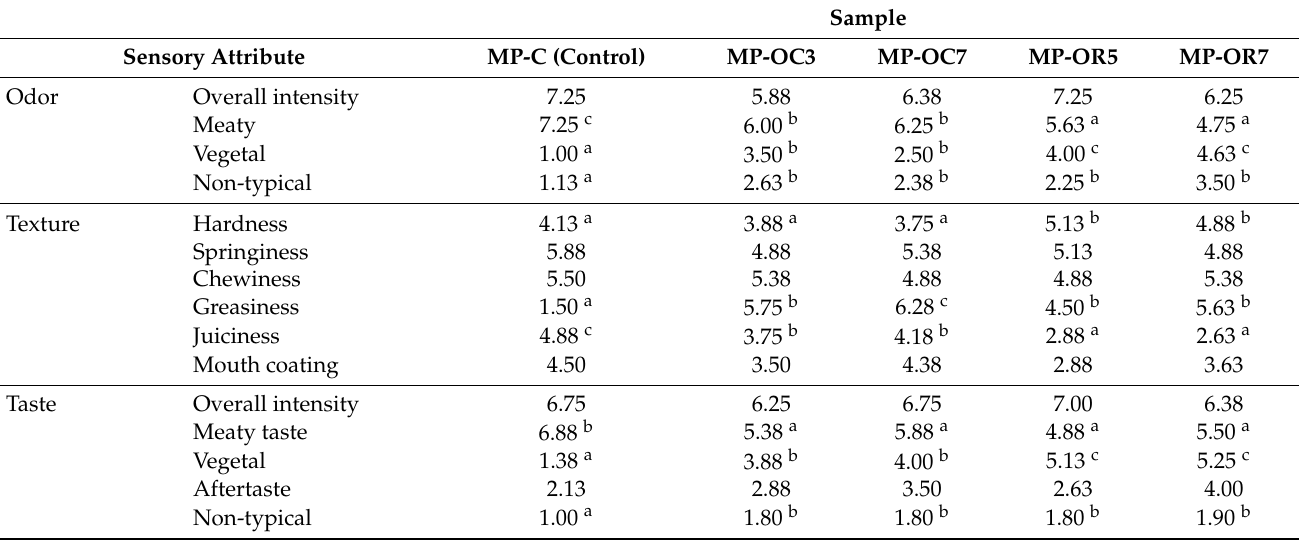
Table 6. Mean scores of the sensory attributes, intensity values of cooked meat patties.